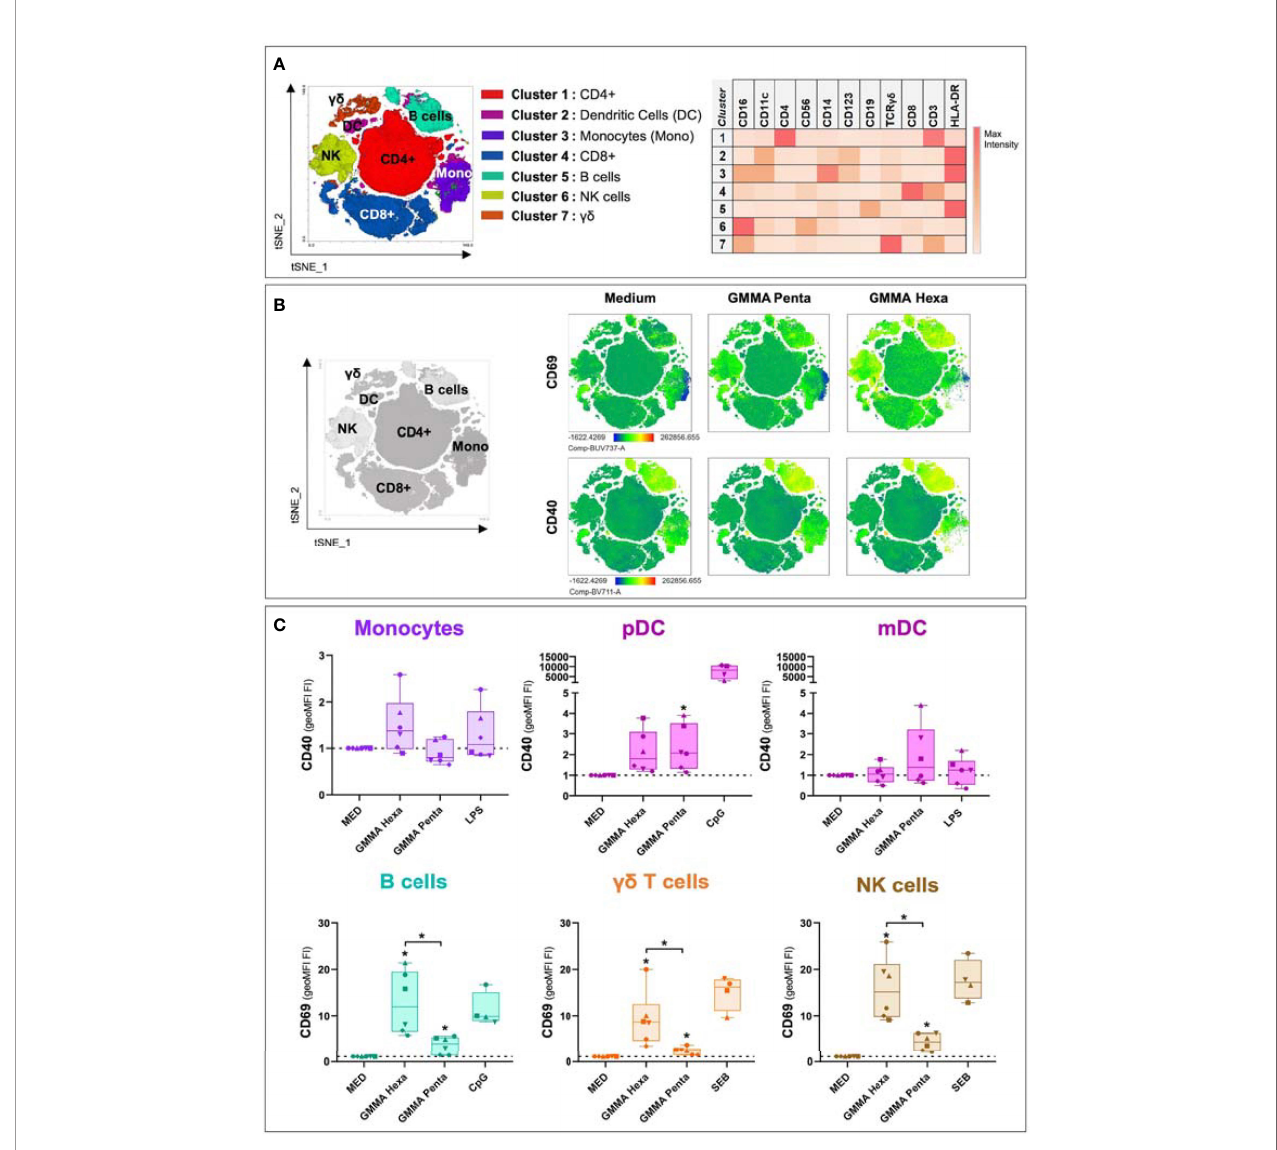
FIGURE 2 | Flow cytometry analysis for activation marker upregulation in different cell populations after 22 hours of stimulation. (A) t-SNE projection of the FlowSOM clustering results. Clusters were assigned to cellular subpopulations according to the expression pro fi le of speci fi c population markers (right panel). (B) t-SNE plots showing the expression of two different activation markers among different conditions. (C) Upregulation levels of CD40 and CD69 in different cellular populations after hPBMCs stimulation with GMMA Hexa, GMMA Penta and speci fi c positive controls. LPS was used as positive control for monocytes and mDC; CpG for B cells and pDC; and SEB for gd T cells and NK cells. Marker upregulation is expressed as fold increase (FI) of the geoMFI with respect to negative control (MED). Dotted lines indicate the reference value of 1 for the control samples. The different dots represent the six different donors. Signi fi cance was estimated using the paired Wilcoxon test (*p < 0.05). Signi fi cant differences with respect to the negative control are indicated on top of each box, instead signi fi cant differences among stimuli are shown explicitly. Non-signi fi cant differences are not